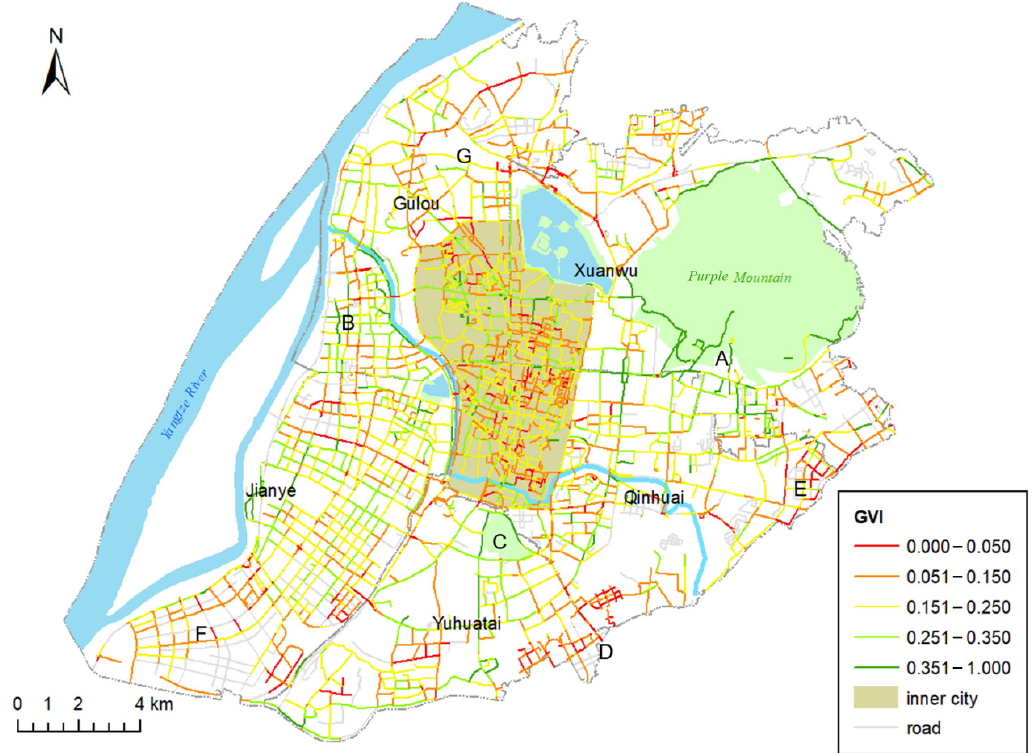
Figure 5. Street–level distributions of the green view index (GVI) in Nanjing. The higher GVI clusters were A, B and C, and the lower GVI clusters were D, E, F and G. In the inner city with its dense road network, the GVI was found to vary a lot, and the values were mostly lower.